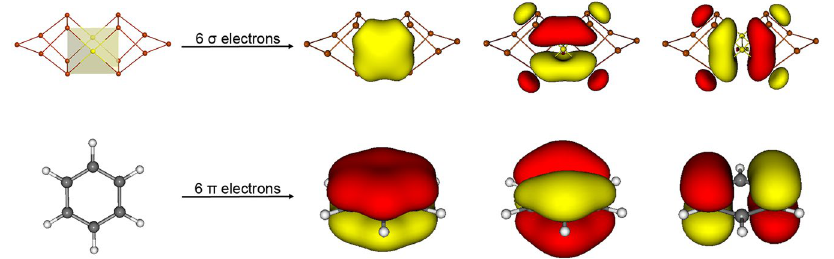
Figure 5. Comparison of one of the σ sextets in [Au 2 Sb 14 ] 4 − ( 2 ) and the prototypical π sextet in benzene. These σ or π bonds are generated from the adaptive natural density partitioning (AdNDP) analysis; two sets of σ sextet are present in [Au 2 Sb 14 ] 4 − ( 2